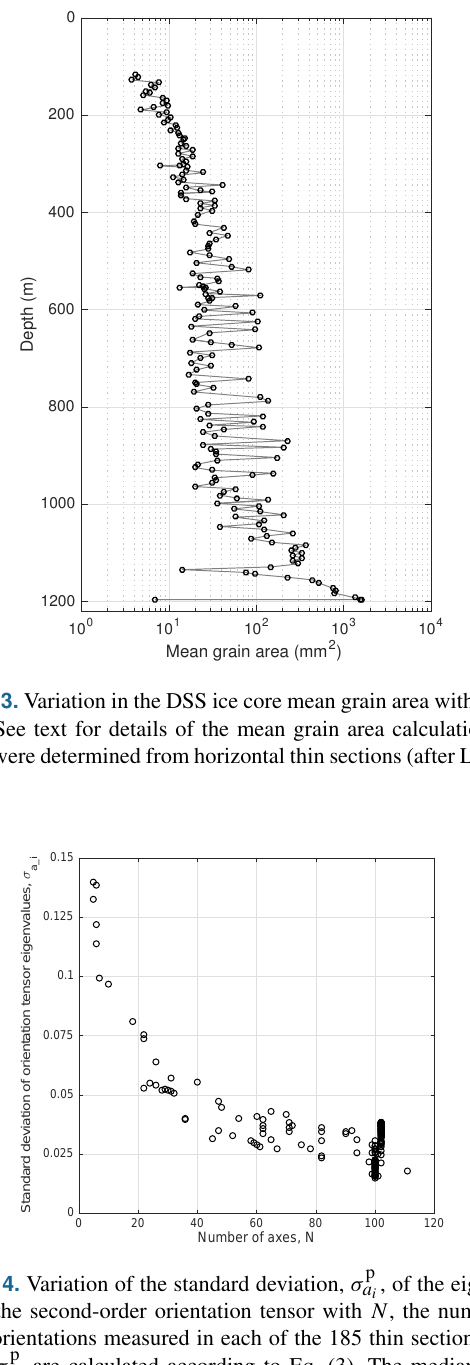
Figure 4. Variation of the standard deviation, σ ues of the second-order orientation tensor with N , the number of c -axis orientations measured in each of the 185 thin sections. Val- ues of σ p a are calculated according to Eq. (3). The median value i of N = 100 and there are 50 measurements at N = 100 and 70 at N = 102.